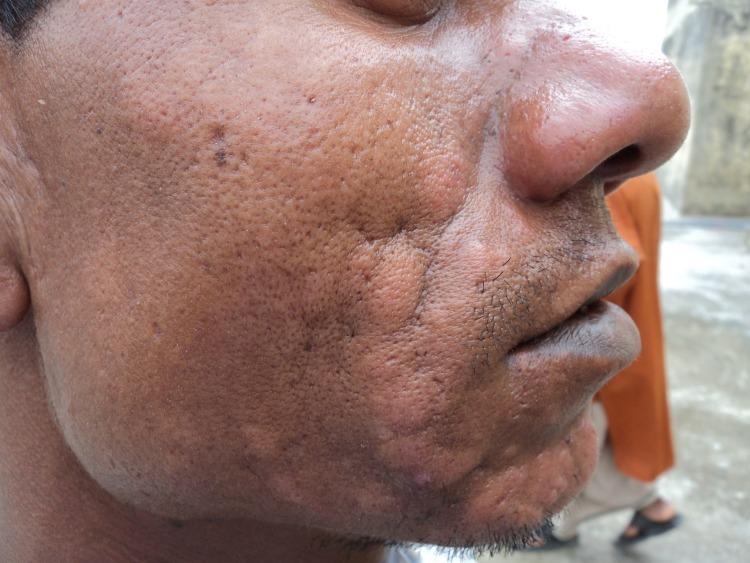
PKDL from Bangladesh: PN rash with infiltration of the cheek and chin.PKDL, post-kala-azar dermal leishmaniasis; PN, papulonodular.